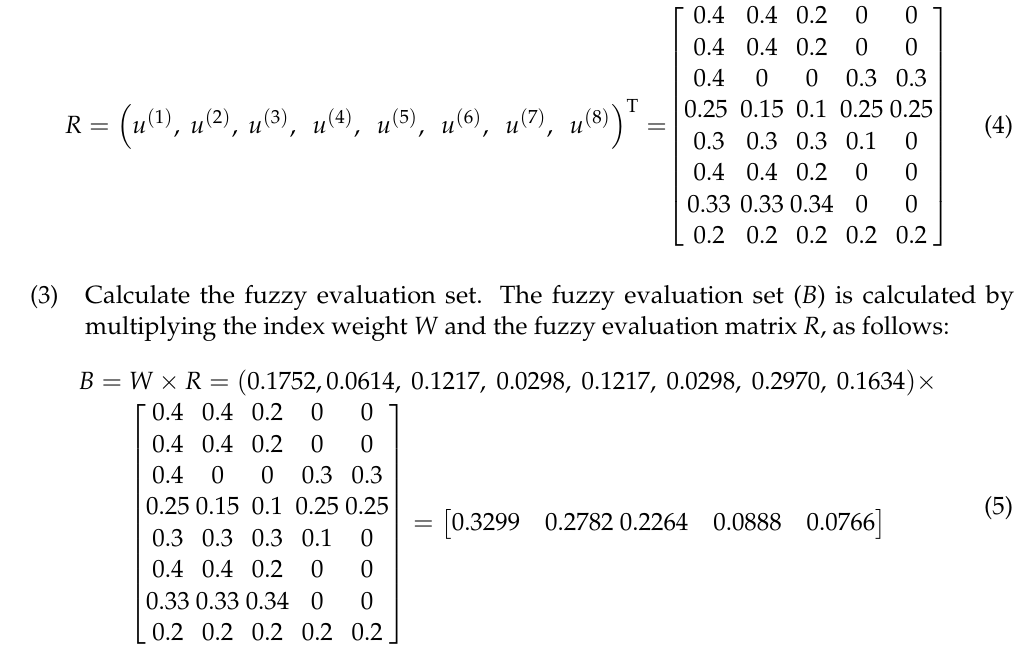
Figure 11. Diagram of hydraulic fractures along the coring trajectory with respect to the adjacent horizontal wells. According to the principle of minimum lateral distance, the fractures were mapped to adjacent horizontal wells. Based on this, the distribution of fracture density in the cored intervals with respect to the lateral distance from the adjacent horizontal wellbores was analyzed, as shown as Figures 12 and 13. It was concluded that in the near-wellbore area with lateral distances less than 20 m–25 m from the wellbore, tensile fractures were pri- marily formed as main fractures, and were evenly expanded within the scope of fractur- ing. In the far-wellbore area, shear fractures formed a high-density area within the range of a 20 m–30 m lateral distance from the wellbore. The induced shear fractures at the tip of the main fractures could explain the multiple fractures in the far-wellbore area [21]. Figure 12. The distribution of shear fracture density with respect to the lateral distance from adja- cent wells. ( a ) H8; ( b ) H9; ( c ) H4.